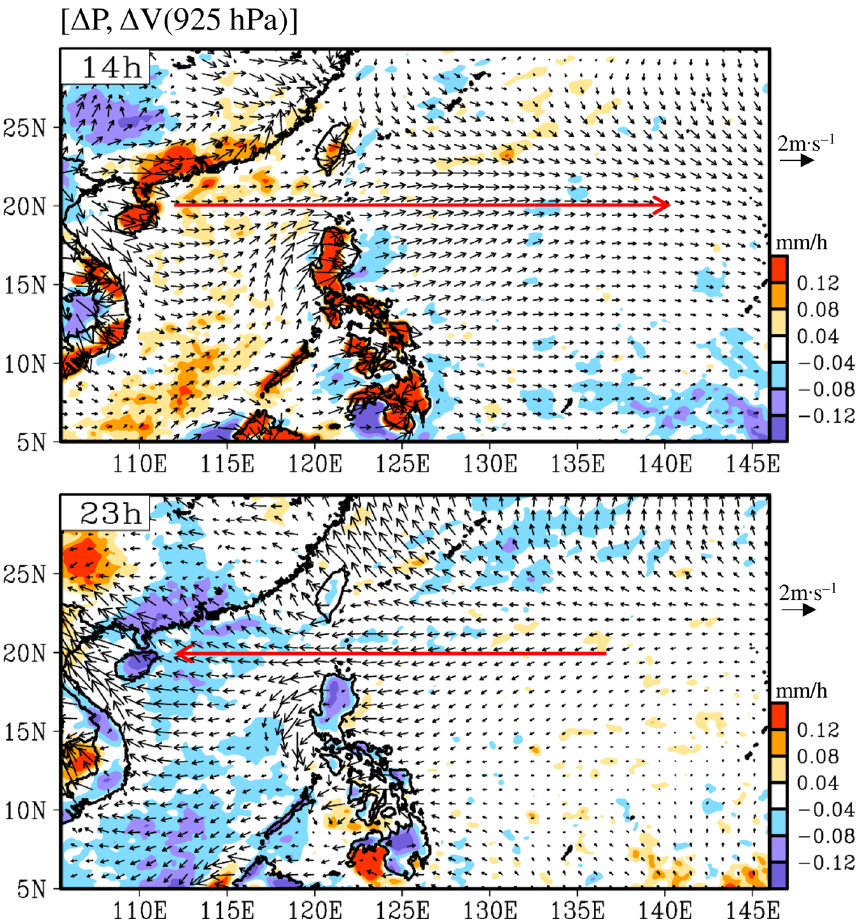
Figure 6. Similar to Fig. 5a, but for the enlarged domain of ΔP (shaded) and 925 hPa wind field (ΔV, vector) at 14 and 23 h (local time in the Philippines). The red arrows indicate the large-scale land–sea breeze (LSB)-like circulation feature. This figure is created using the software of GrADS